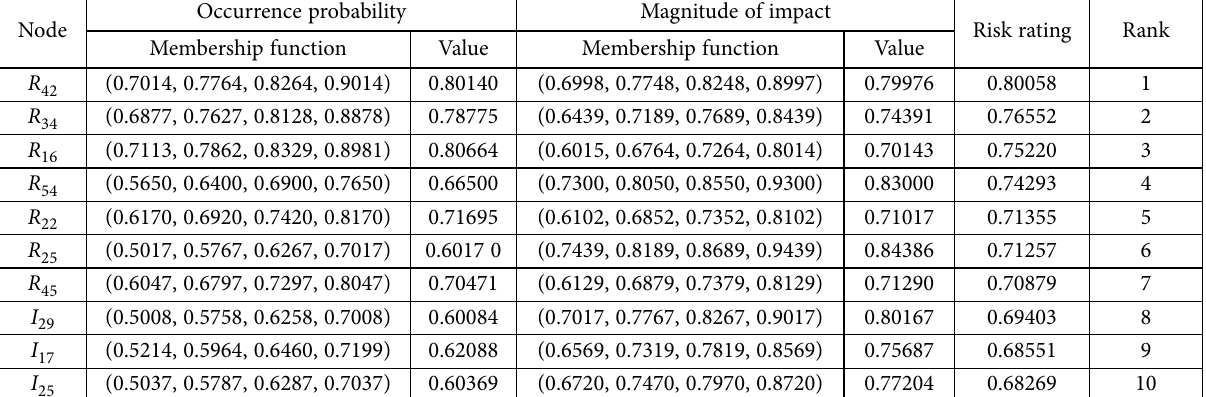
Table 6. RA results of top ten RFs in the first level for the Ankara-Istanbul high-speed railway project Occurrence Node